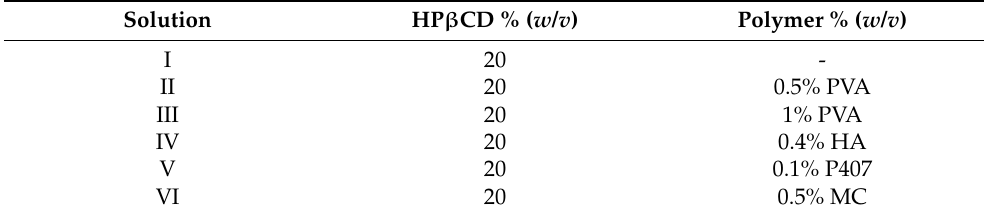
Table 1. Composition of polymeric solutions to assess the potential increase in water solubilization efficiency of